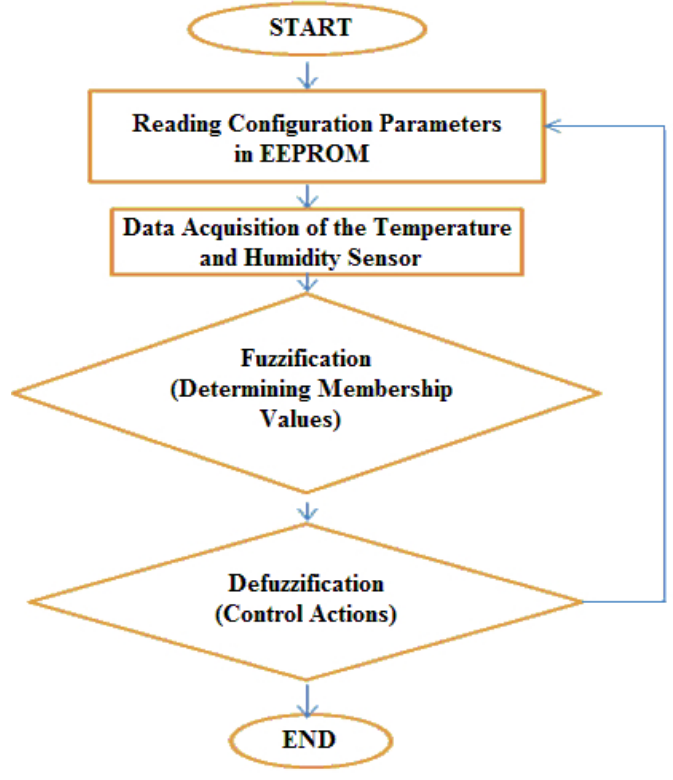
Figure 5. Flowchart for the fuzzification and defuzzification processes.